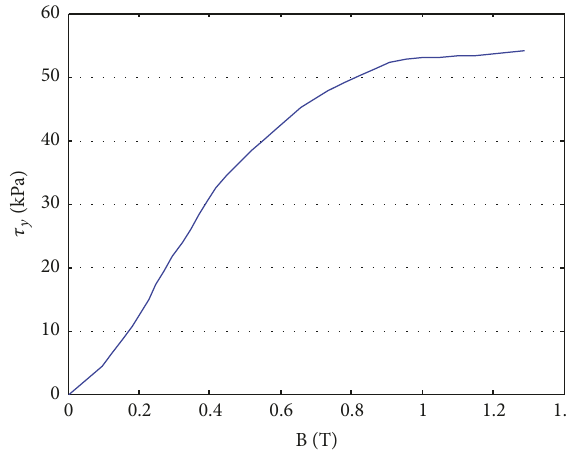
Figure 5: 𝐵 − 𝐻 curve of Steel 45.